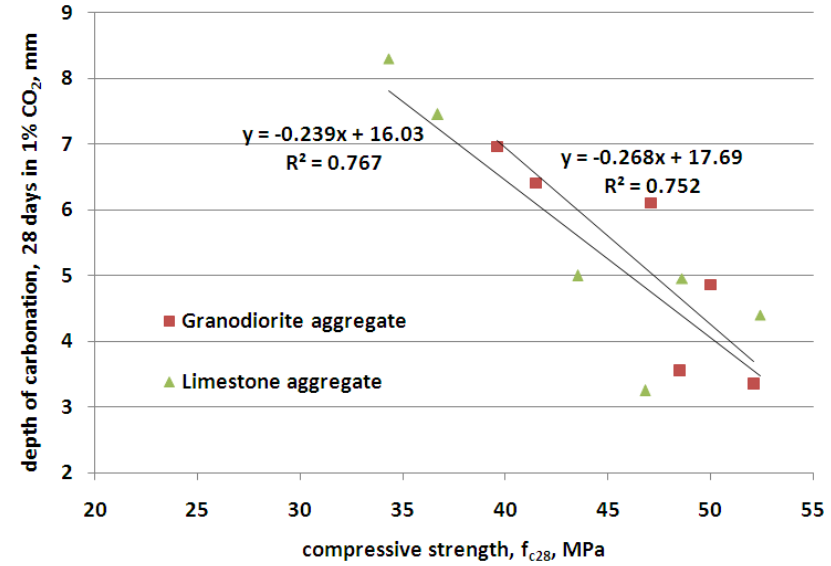
Figure 10. Relationship between carbonation depth of concrete and compressive strength in concretes with granodiorite and limestone aggregate.